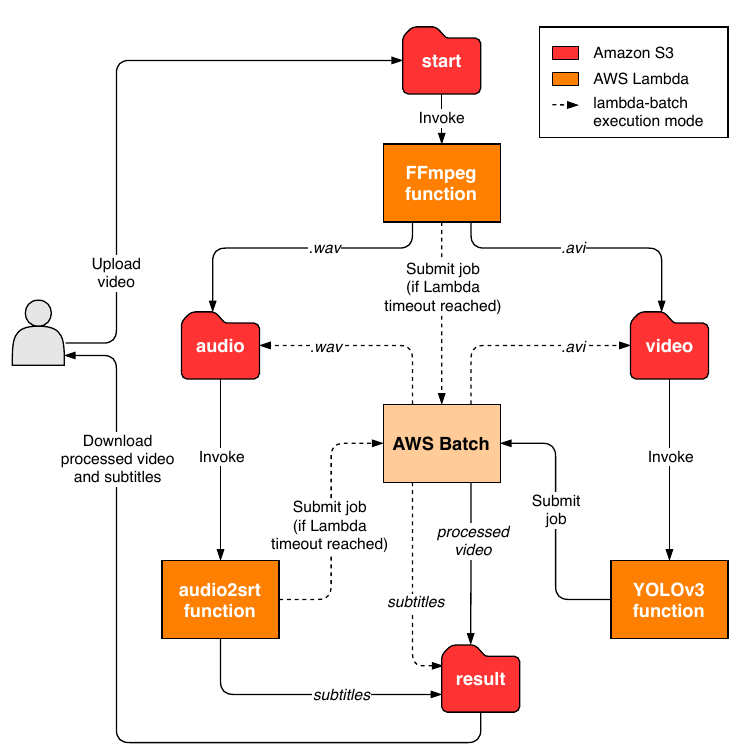
Figure 3. Simplified diagram of the multimedia processing